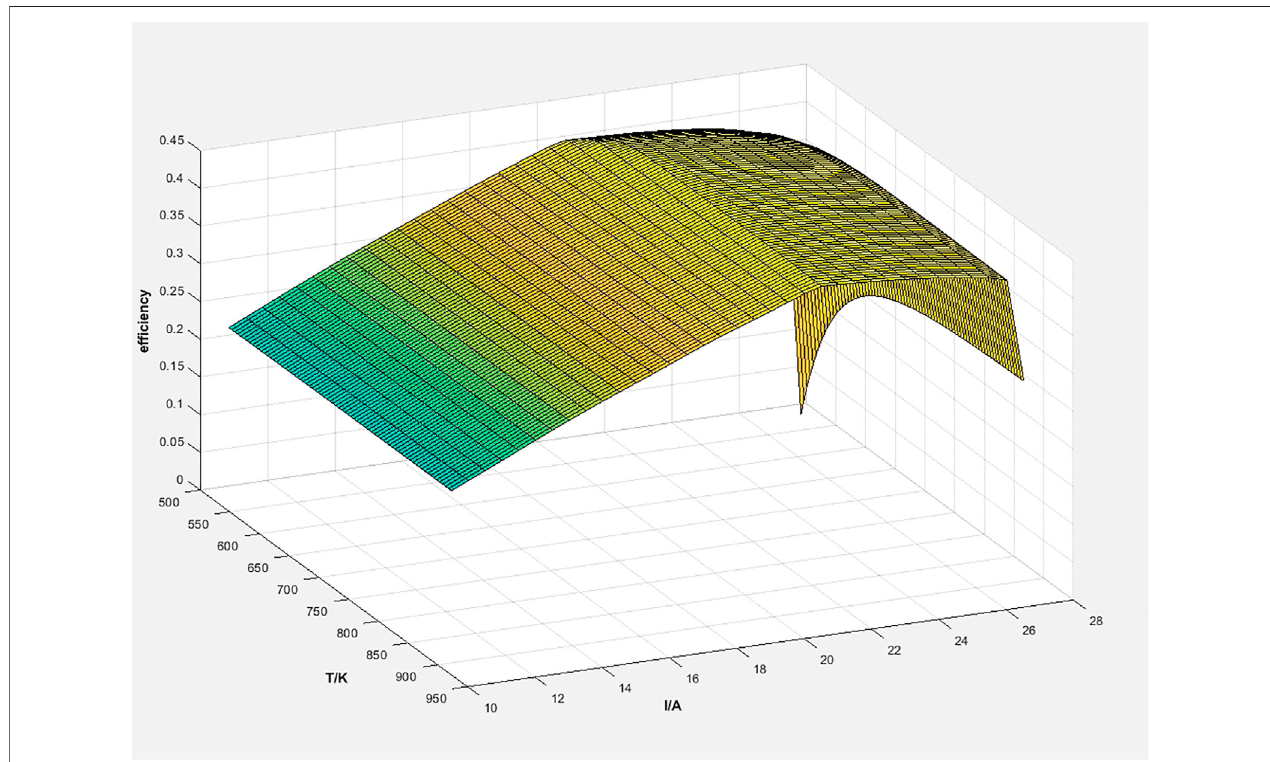
FIGURE 3 | The ef fi ciency of the system at different temperature and current.